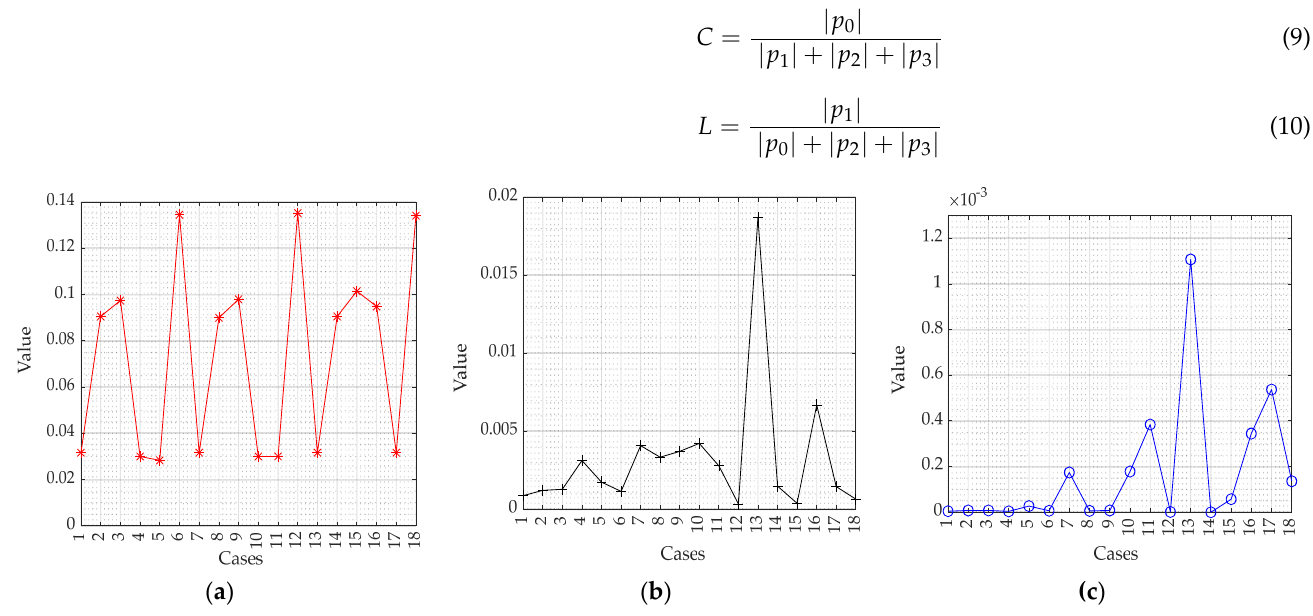
Figure 11. Error and features of the transformations coefficients. ( a ) Error, ( b ) linearity, ( c ) con- stancy.